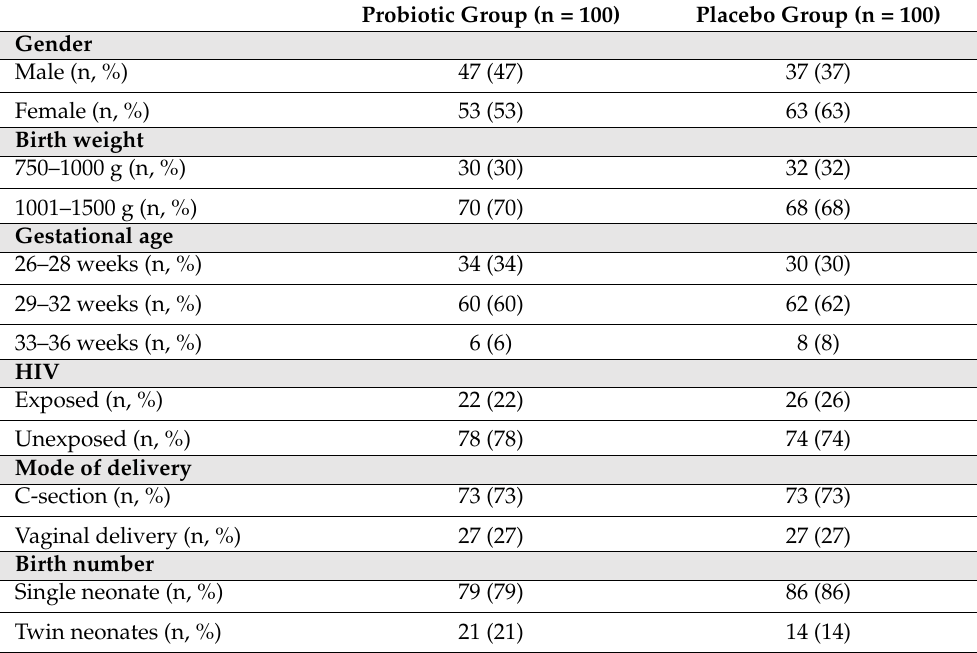
Table 1. Neonatal data of the neonates enrolled in the